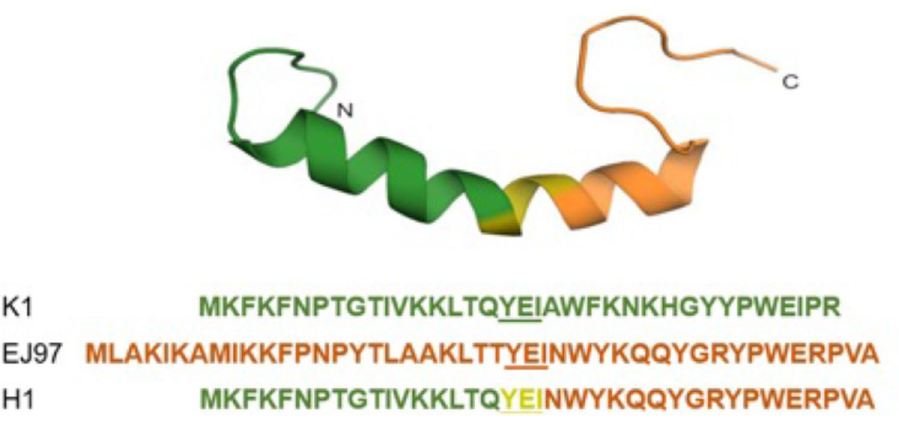
Figure 1. Predicted Structure and amino acid sequence of the hybrid bacteriocin and its parental bacteriocins. The predicted structure of the hybrid bacteriocin 1 (H1), formed by the N-terminal part of K1 (green) and the C-terminal part of EJ97 (orange). The central tripeptide sequence (YEI—underlined) in K1 and EJ97 serves as the joining segment in the fusion protein. The structure of H1 was modeled based on the NMR structural data of K1 23 using the structure prediction tool Swiss model 35